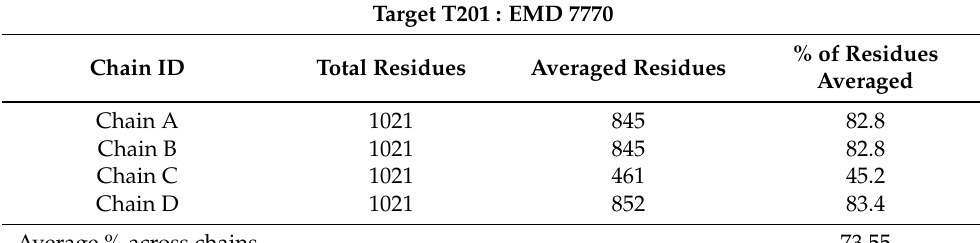
Table 1. Number of residues averaged for target T201: EMD 7770.